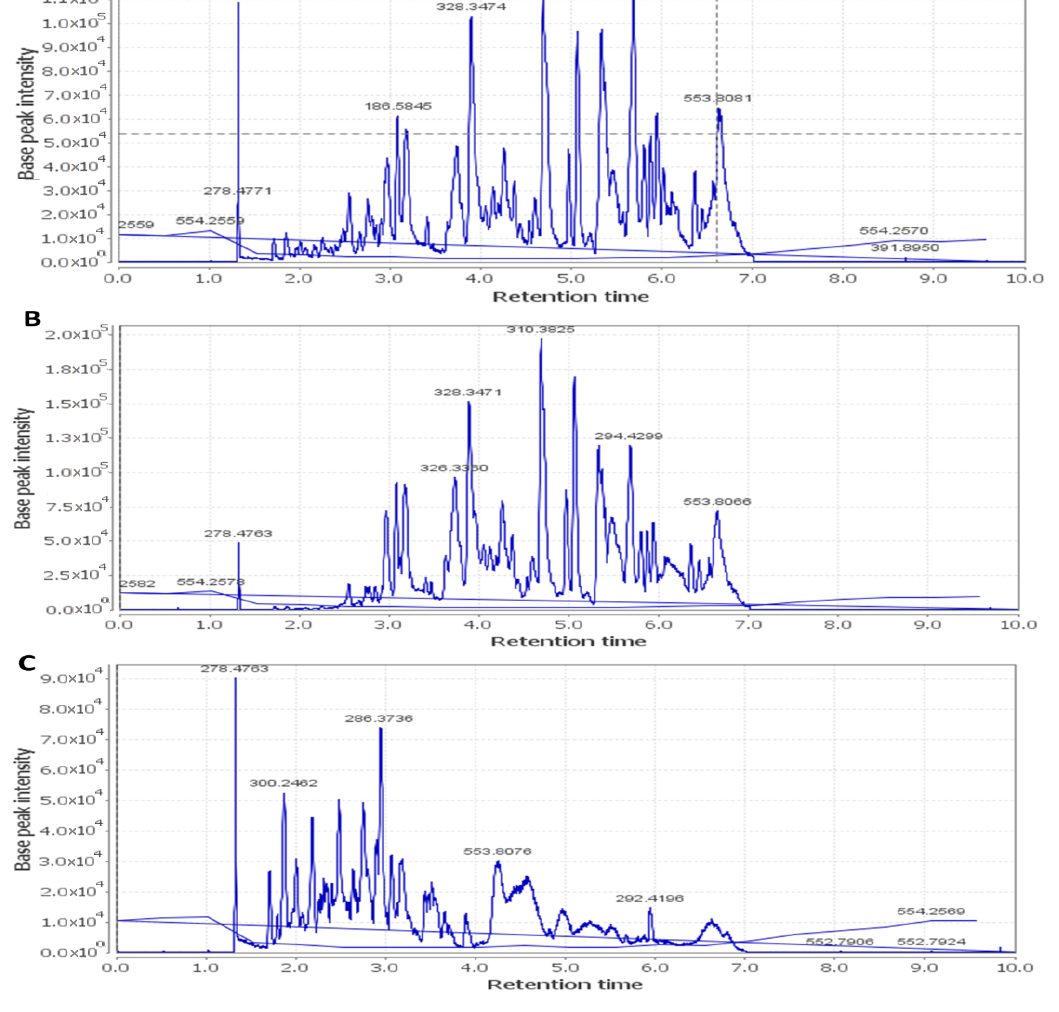
Figure 1. Total ion chromatogram of Hibiscus schizopetalus recorded in negative ionization mode. ( A ) Ethanolic extract (Et-E); ( B ) Dichloromethane fraction (DCM-F); ( C ) n-Butanol fraction (Bu-F).